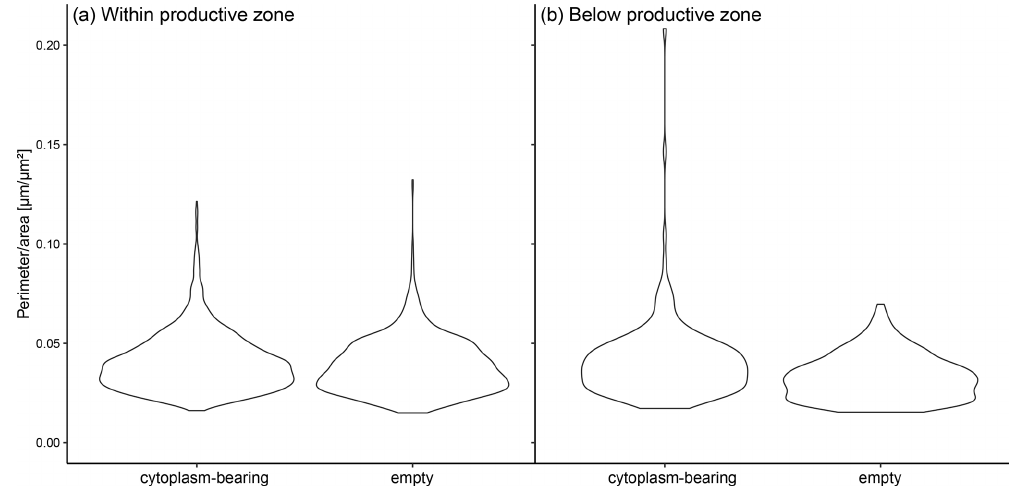
Figure A2. The ratio of perimeter to area in individual shells of N. pachyderma in samples from PS 93.1 divided by the status (cytoplasm- bearing and empty). Panel (a) represents the shells from within the calculated productive zone of the individual stations and (b) those from below the productive zone.